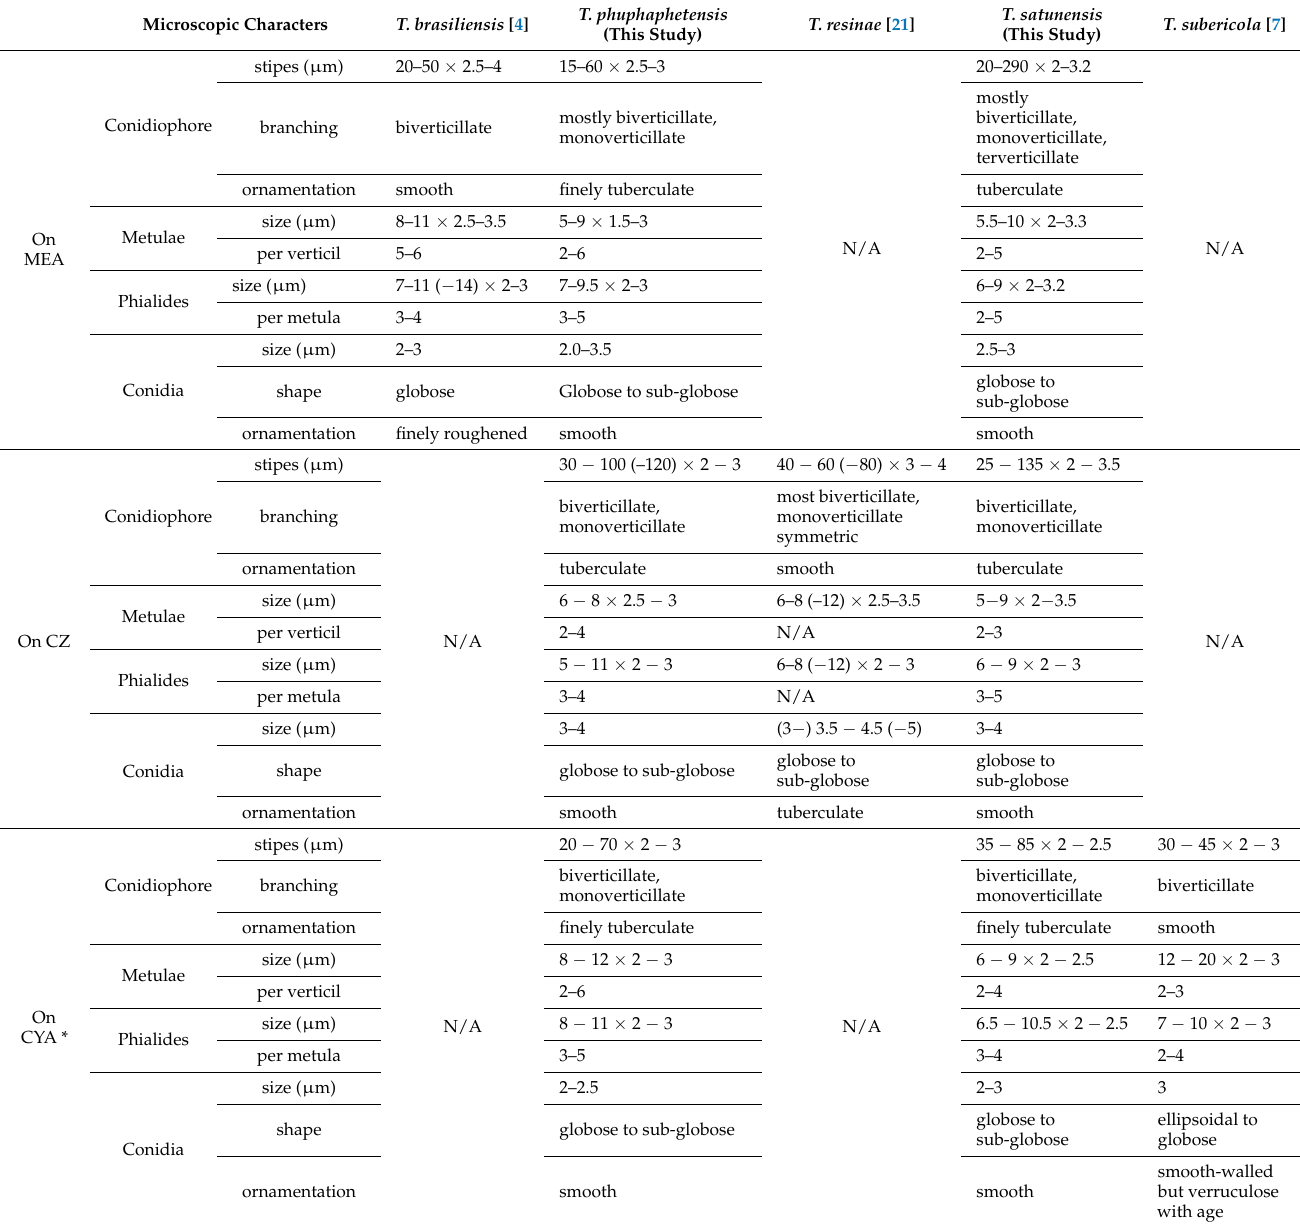
Table 3. Comparisons of the morphological characteristics of T . phuphaphetensis sp. nov. (TBRC 16281), T . satunensis sp. nov. (TBRC 16246), and closely related species of Talaromyces section Trachyspermi based on the phylogeny in this